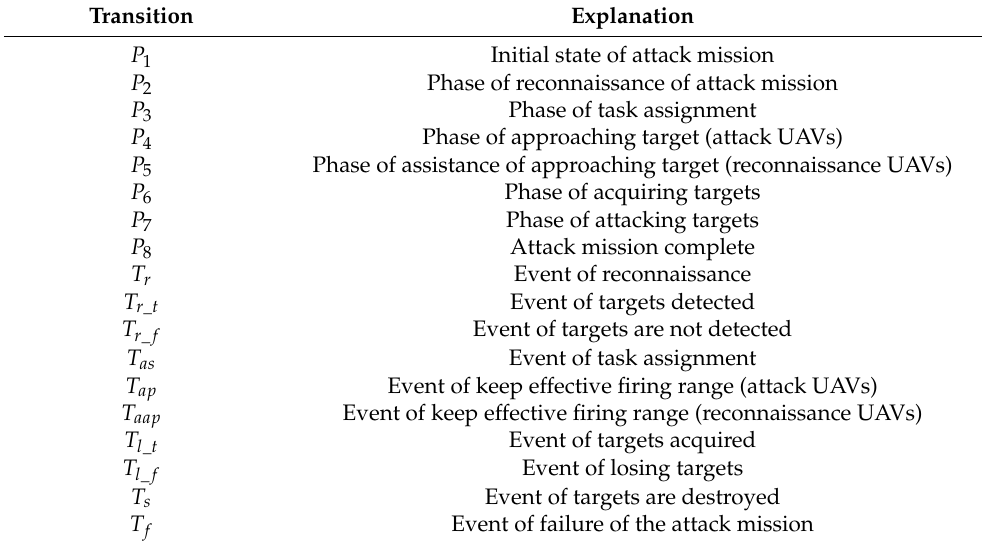
Table 1. The explanation of